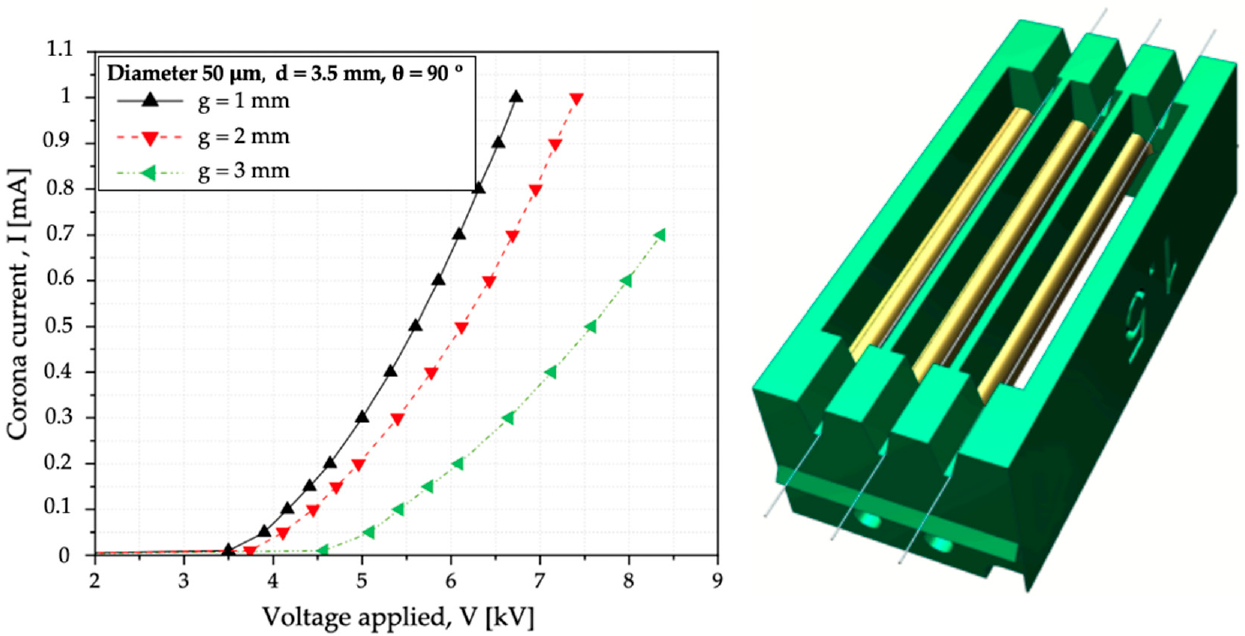
Figure 11. CVCCs of the scaling of the EMBID configuration with several gaps (1, 2 and 3 mm). In parallel, the airflow’s total pressure and efficiency curves for the three EMBID geometries are analyzed in three operating power values (1.3 W, 2.6 W, and 3.9 W). The data are obtained from the velocity tests with a constant operating electrical power with variable output areas for each device. As can be seen in Figure 12, an increase in electrical power raises the total pressure generated by the device, that is, by a higher initial static pressure value. Lastly, the pressure drop is less pronounced in the middle. As for the pressure drop described, this phenomenon is due to the regime transition of the flow itself. The evolution of efficiency with respect to airflow offers a maximum. This maximum point is a relationship between the mechanical and electrical powers consumed. For the presented designs, the best efficiency is determined for the arrangement with space g = 3 mm ( η = 0.38%). Consecutively, the paramount airflow rate with AR = 140 lmp